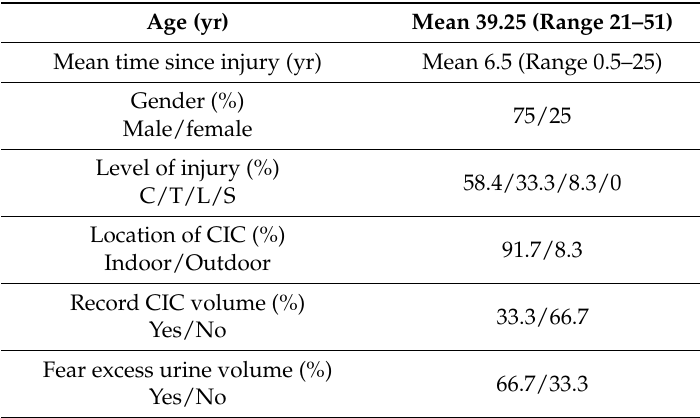
Table 3. Demograghic and clinical features ( n = 12).